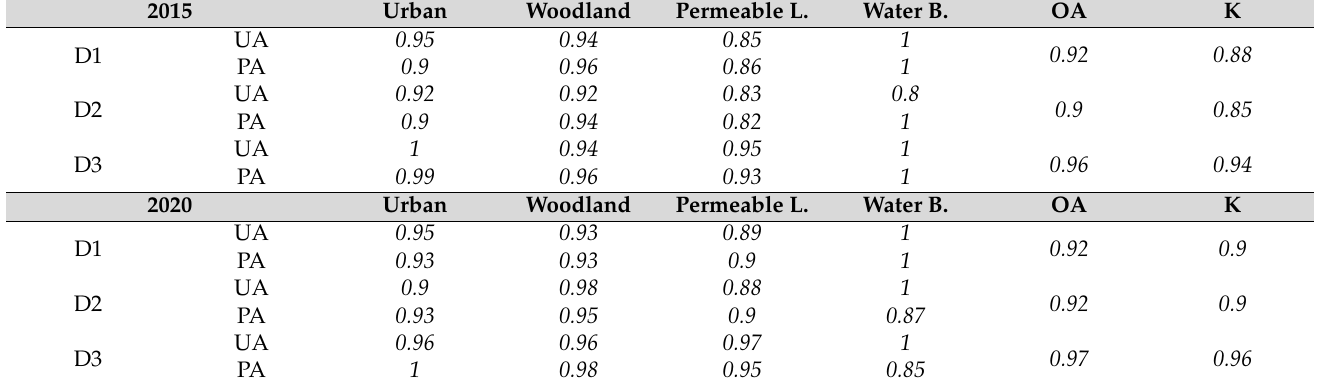
Table 5. Accuracy metrics of the different datasets derived from Landsat-8.